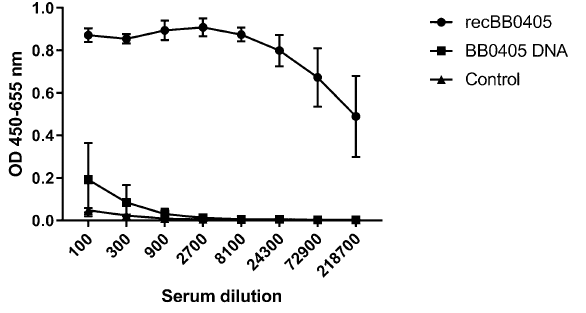
Figure 2. Enzyme-linked immunosorbent assay (ELISA) showing high-titer antibodies induced in recombinant BB0405 immunized mice. BB0405 specific total IgG responses were measured in mice sera of three vaccination groups with 8 mice each. IgG responses are presented as optical density (OD) 450–655 nm for multiple sera dilutions. The first group was immunized at three time points (0, 14 and 28 days) with recBB0405. The second groups received DNA vaccinations at the same time points with DNA BB0405 and the third group with DNA Empty (negative control). Plates were coated with recombinant BB0405 and incubated with mouse sera, which was collected from mice at time point 42 days, just before tick challenge and after three vaccinations. Sera was diluted in steps of 300 until 1: 218700.